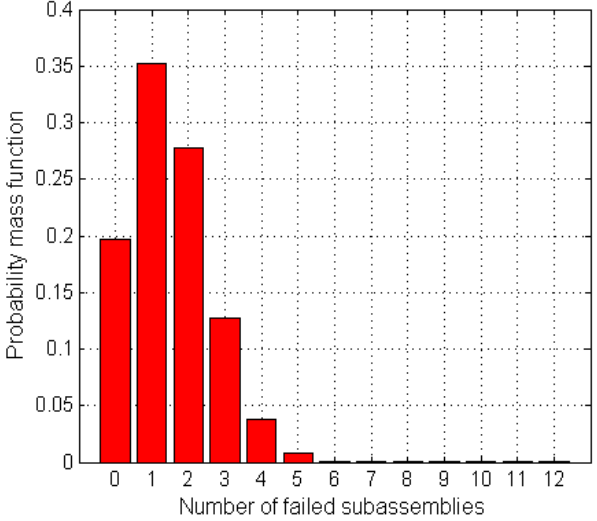
Figure 1. Annual system failure probability mass function in terms of the number of subassembly failures.